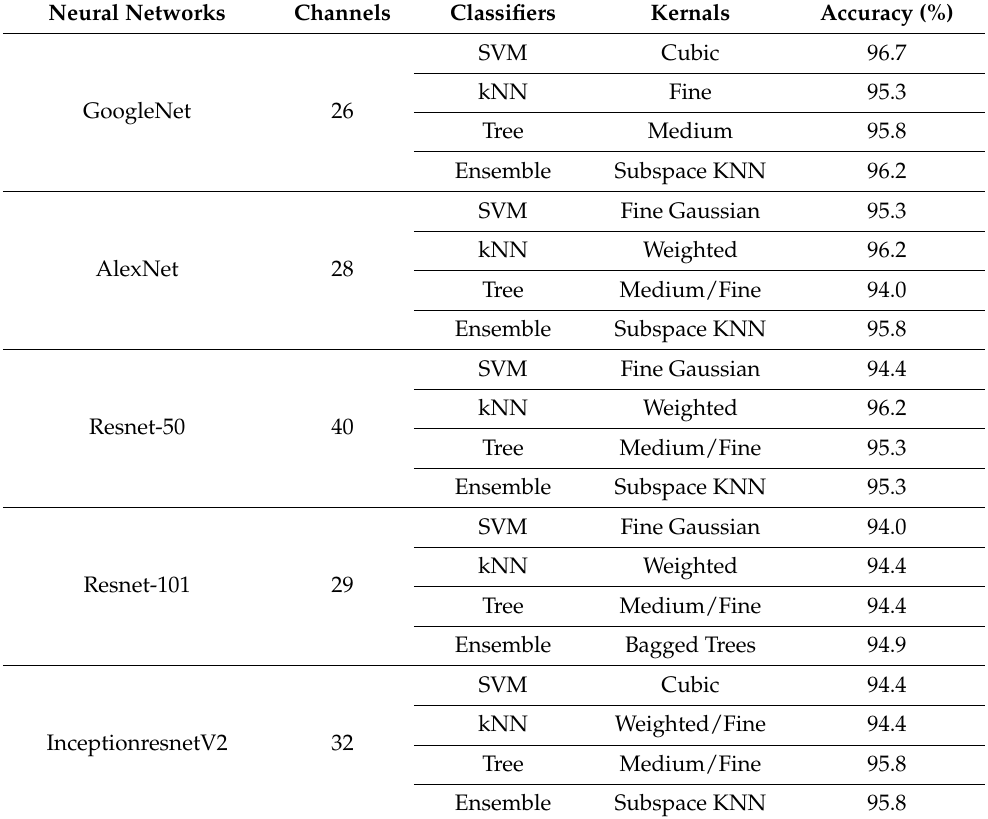
Table 3. Analysis of accuracy following channels reduction of various deep learning